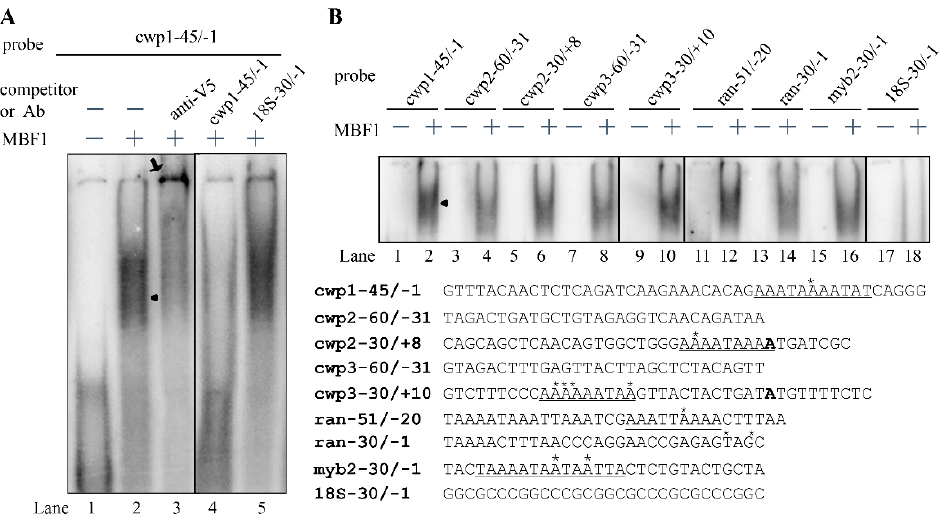
Figure 4. DNA-binding ability of MBF1 revealed by electrophoretic mobility shift assays. ( A ) Detection of MBF1 binding sites. Purified MBF1 and the 32 P-end-lableled oligonucleotide probe cwp1-45/-1 (-45 to -1 relative to the translation start site of the cwp1 gene) were used in electrophoretic mobility shift assays. Binding reaction mixtures contained the components indicated above the lanes. For competition and supershift assays, some reaction mixtures contained 200-fold molar excess of cold oligonucleotides cwp1-45/-1 or 18S-30/-1 or 0.8 μ g of anti-V5-horseradish peroxidase (HRP) antibody. The arrowhead and arrow indicate the shifted complex and supershifted band, respectively. ( B ) MBF1 binding sites in various promoters. Purified MBF1 and various 32 P-end-lableled oligonucleotide probes as indicated above the lanes were used in electrophoretic mobility shift assays. The arrowhead indicates the shifted complex. The transcription start sites of the cwp1-3 and myb2 genes in 24-h encysting cells are indicated by asterisks. The transcription start sites of the ran gene determined from vegetative cells are indicated by asterisks. The transcription start sites are within the AT-rich initiator (Inr) elements, which are underlined. The translation start sites of the cwp2 and cwp3 genes are in bold. “18S” represents 18S ribosomal RNA.